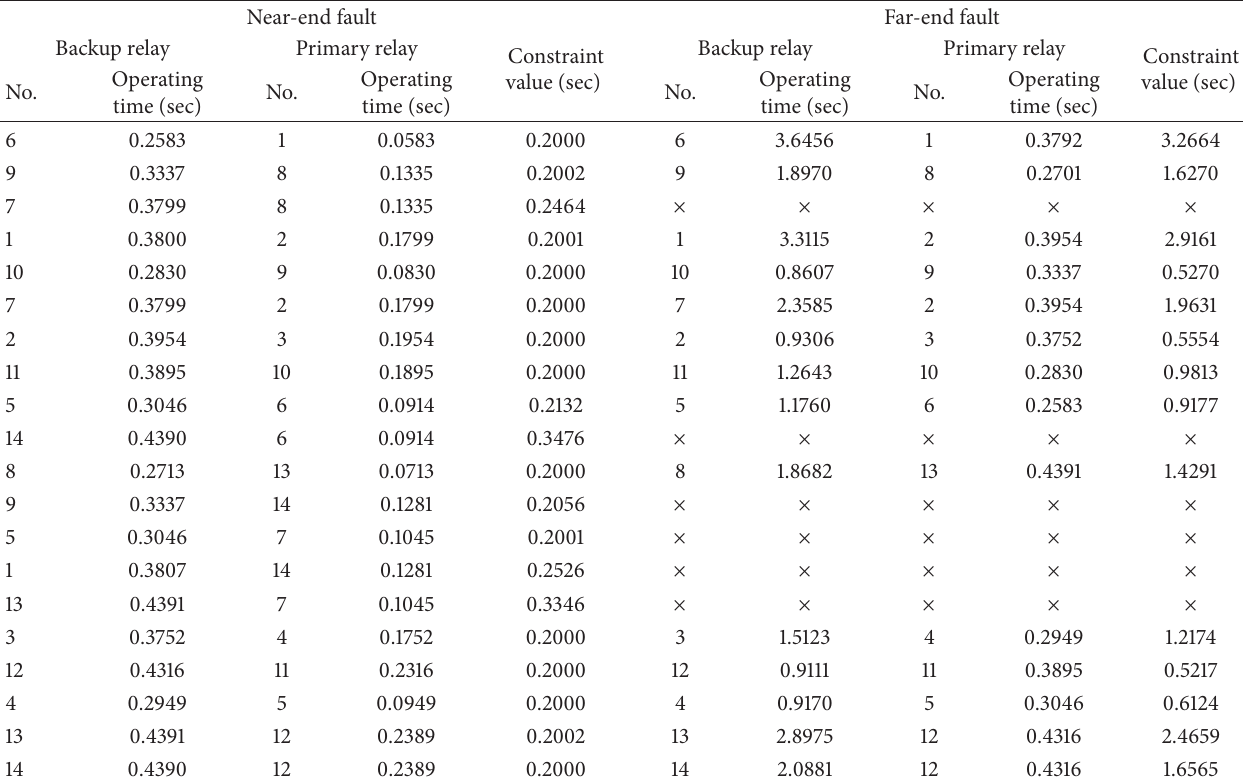
Table 3: Operation times of primary/backup relay pairs in a fixed network topology (with near-end faults and far-end faults) using the proposed NM-PSO method.